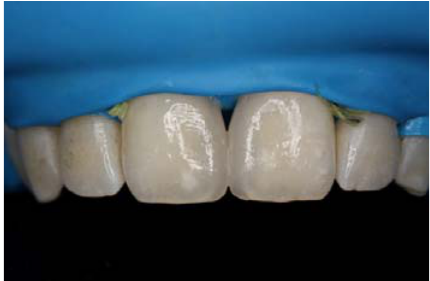
Figure 7: Polishing discs were used for detailed polishing from rough to fine grit.